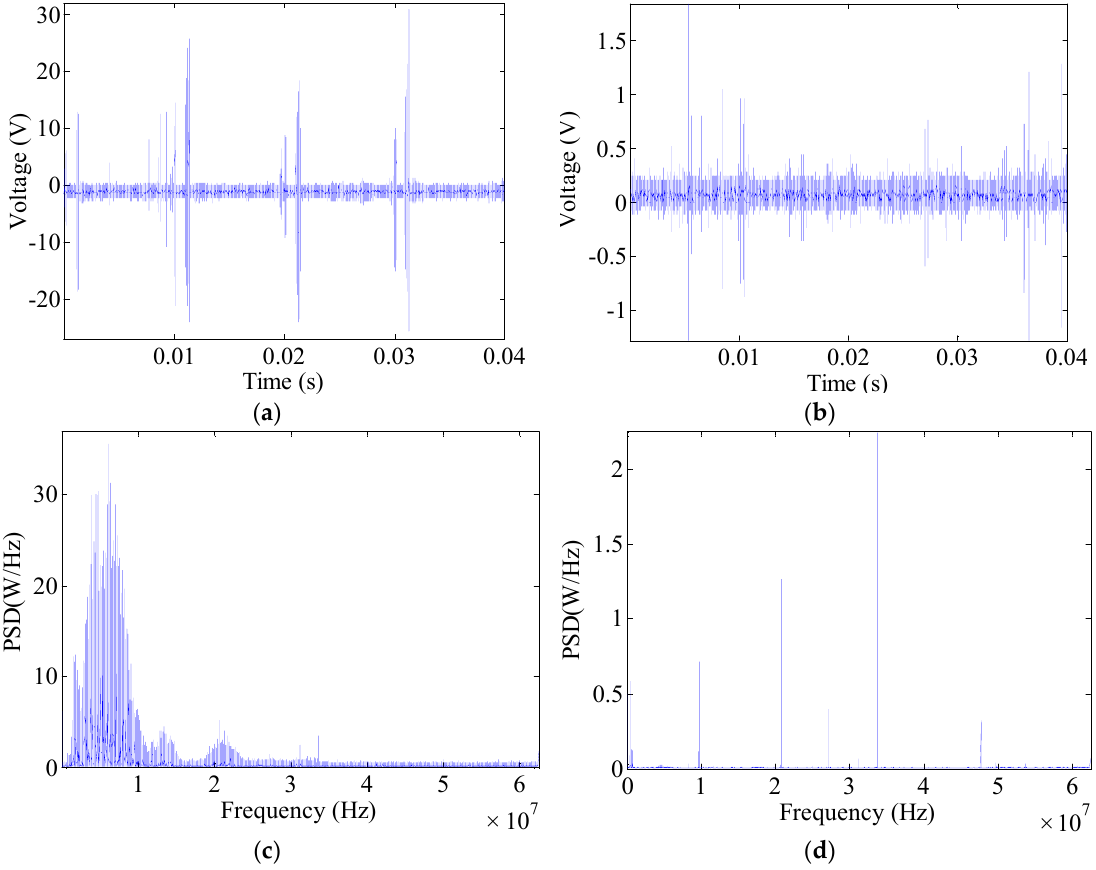
Figure 6. Signal analysis of an electrical drill: ( a ) high-frequency signals of arc faults; ( b ) high-frequency signals under normal operation; ( c ) PSD of arc fault signals; ( d ) PSD under normal operation.